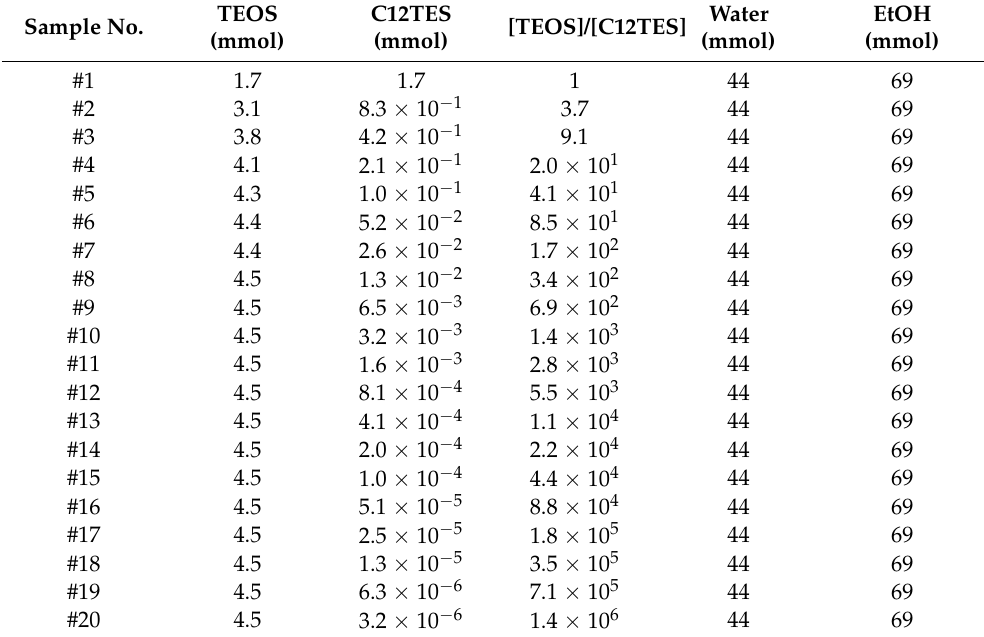
Table 1. The molar ratios of precursor compounds of the alkylsilane-derived hybrid films. Sample